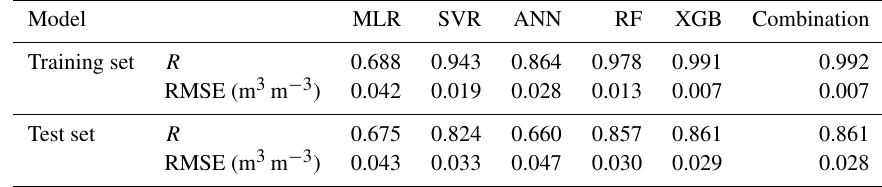
Table 4. Accuracy of the models based on correlation coefficient ( R ) and root mean square error (RMSE).